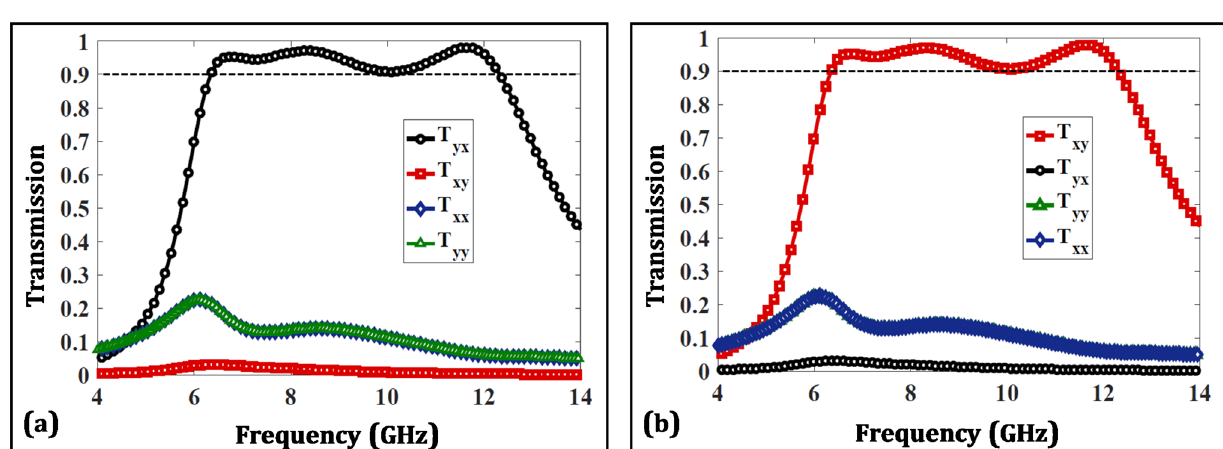
Figure 4. ( a ) Plotted chirality parameter for the structure. ( b ) Plotted FOM on chirality parameter.